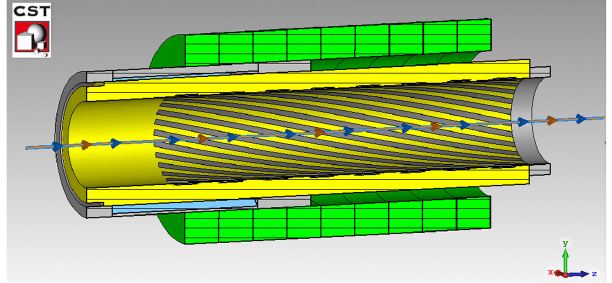
FIG. 7. Helical beam screen (cut-down model).